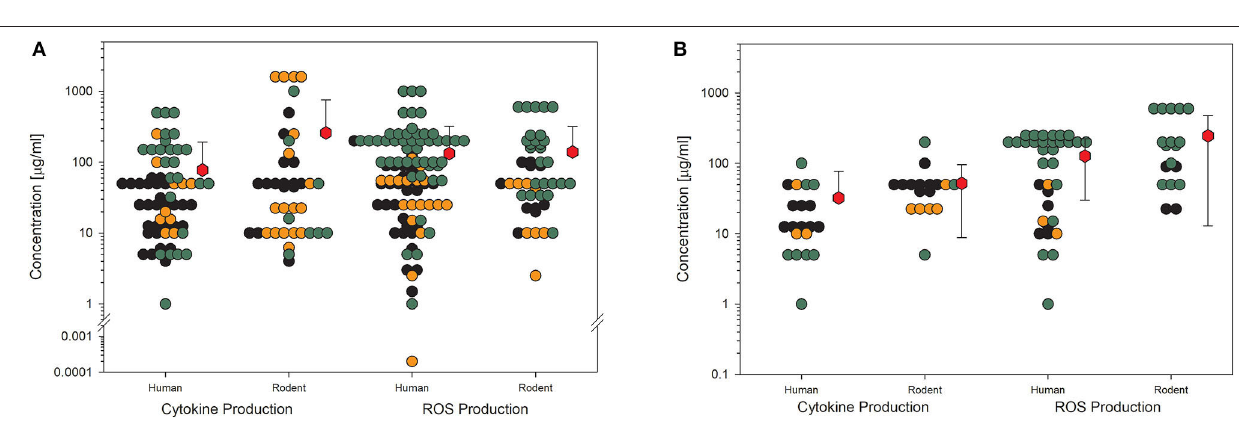
Frontiers in Public Health |